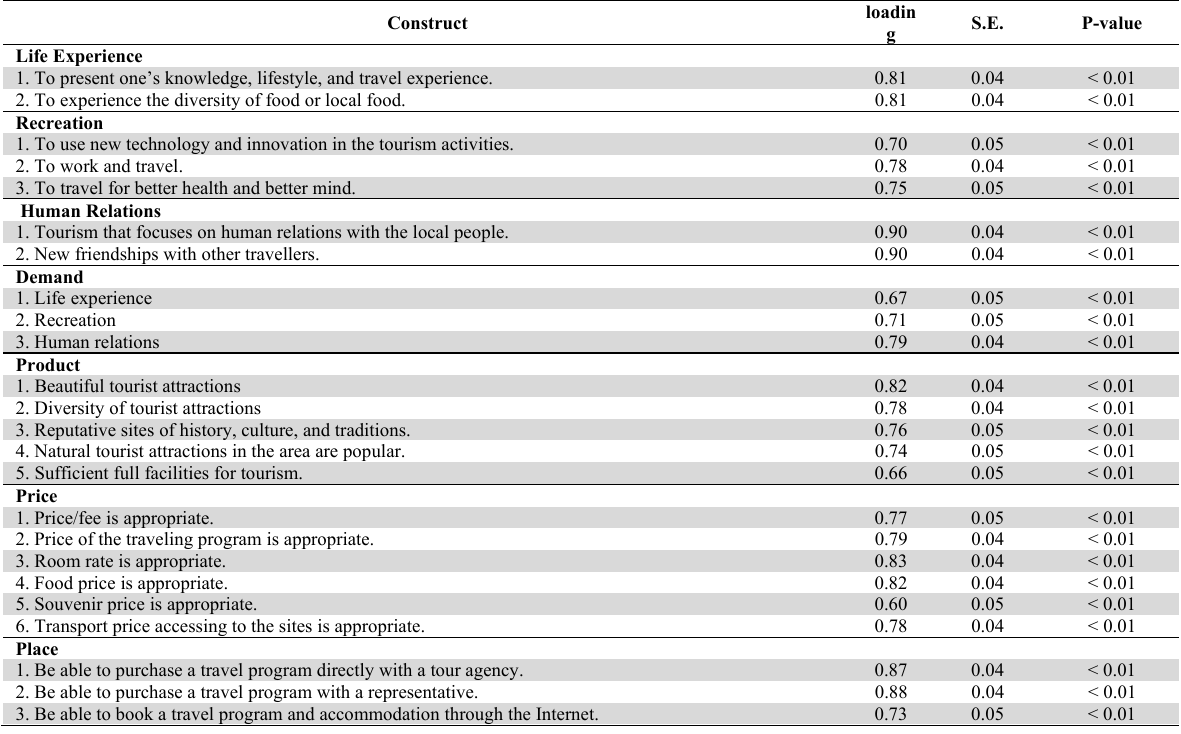
Convergent validity of the reflective latent measurement